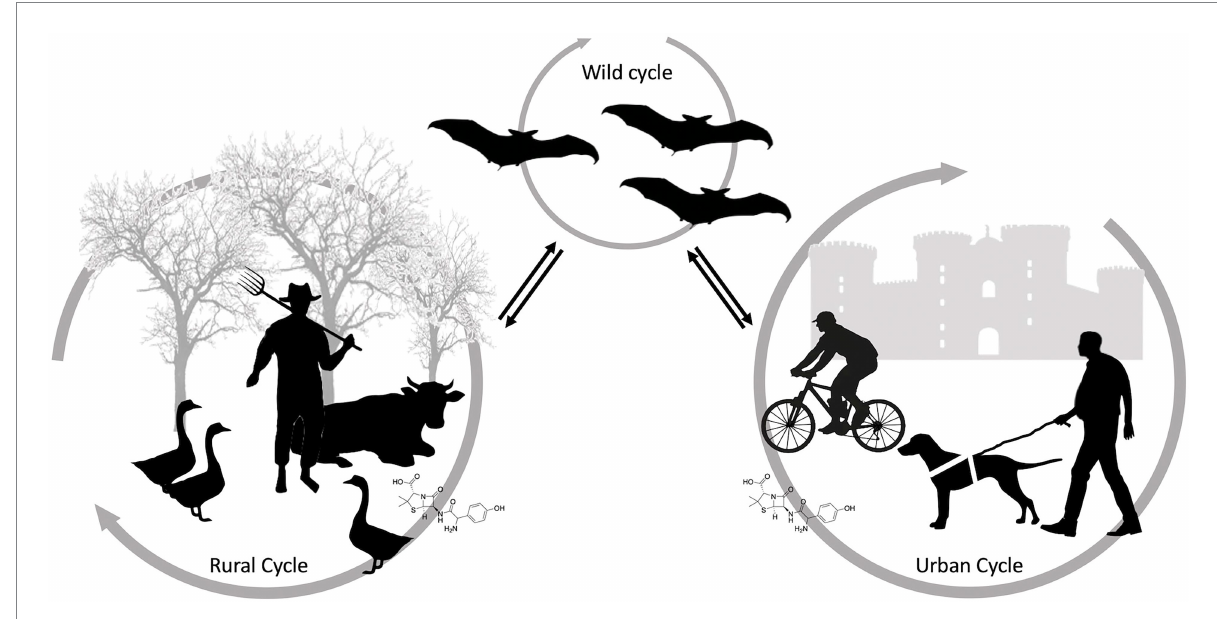
FIGURE 4 Schematic representation of antimicrobial resistance transmission pathways between anthropogenic and natural